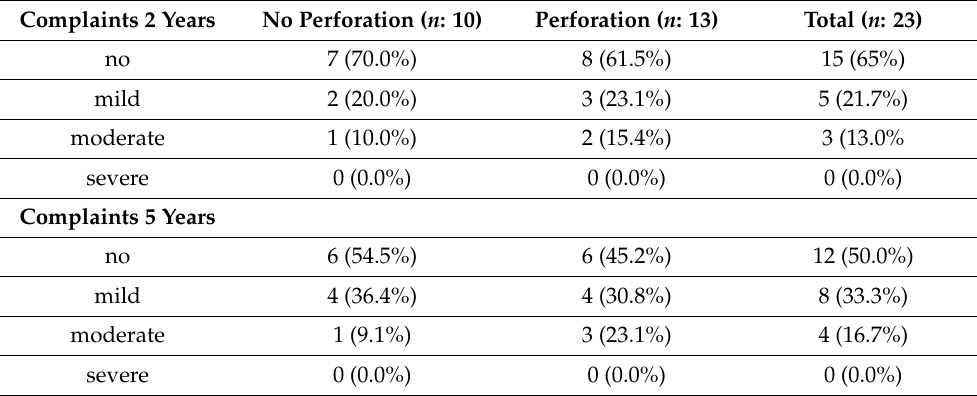
Table 4. Rhinosinusitis Symptom Severity Score (RS-SSS) questionnaire, 2- and 5-year outcome with or without